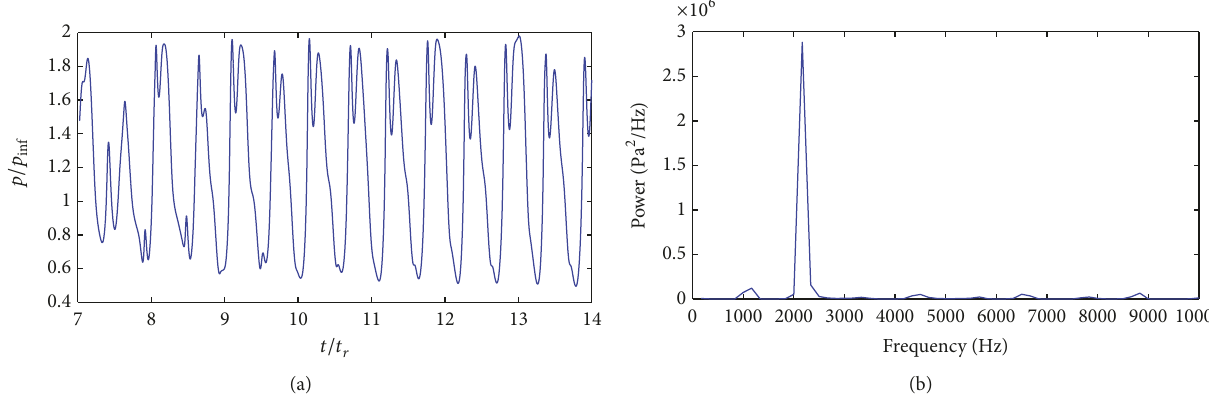
Figure 9: The results for the control point for baseline case. (a) Pressure distribution. (b) FFT analysis of the pressure data.